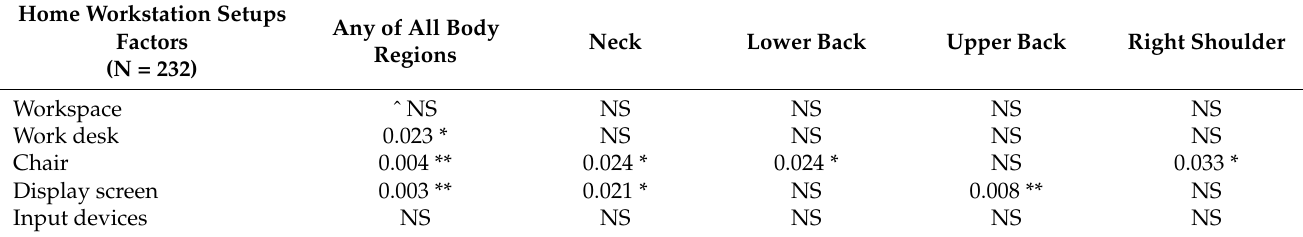
Table 6. Summarised results of home workstation setup factors associated with self-reported muscu- loskeletal